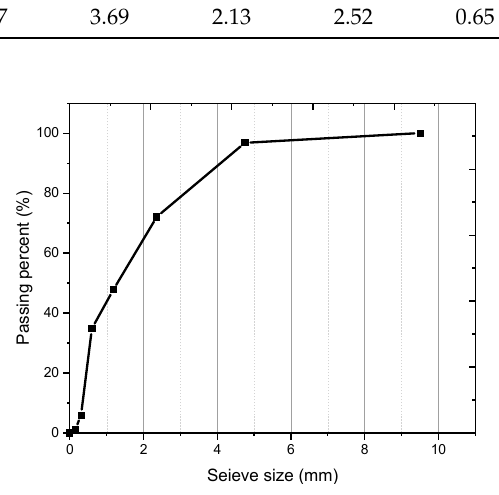
Figure 1. Fine aggregate gradation. Table 2. Mixture composition for cement mortar (kg/m 3 , SP content was by the mass of